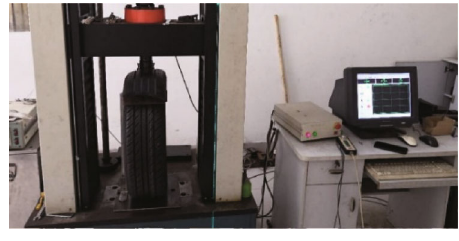
Figure 4: Static loading test.